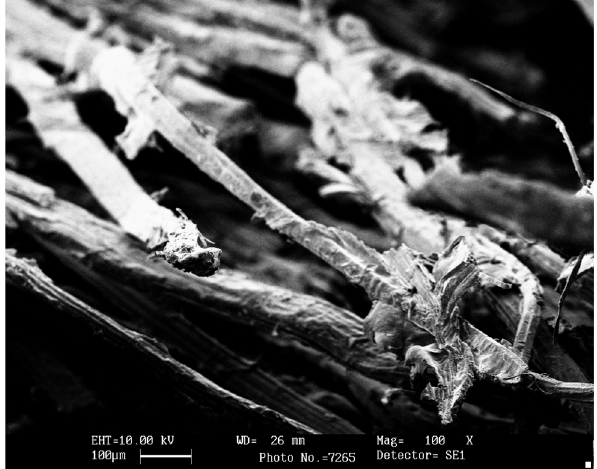
Figure 23: SEM for (5% jute fiber by weight) composite material without